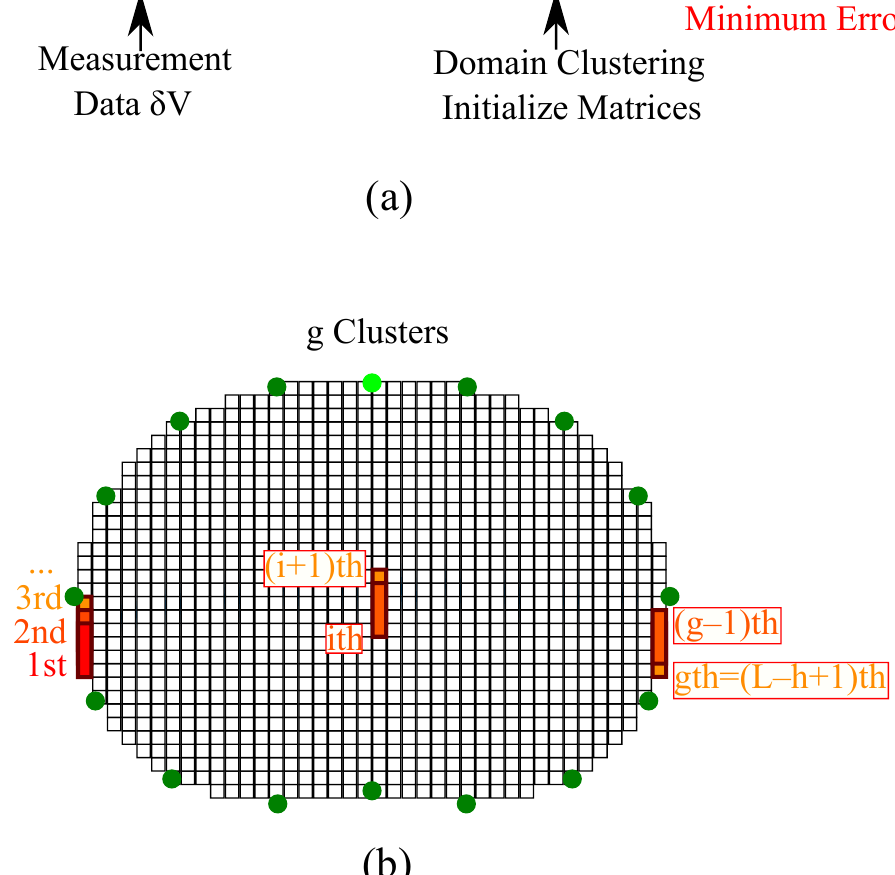
Figure 1. ( a ) Simplified demonstration of the PM-MoM SBL method process. ( b ) Illustrative example of a thoracic pixelized domain’s clustering structure